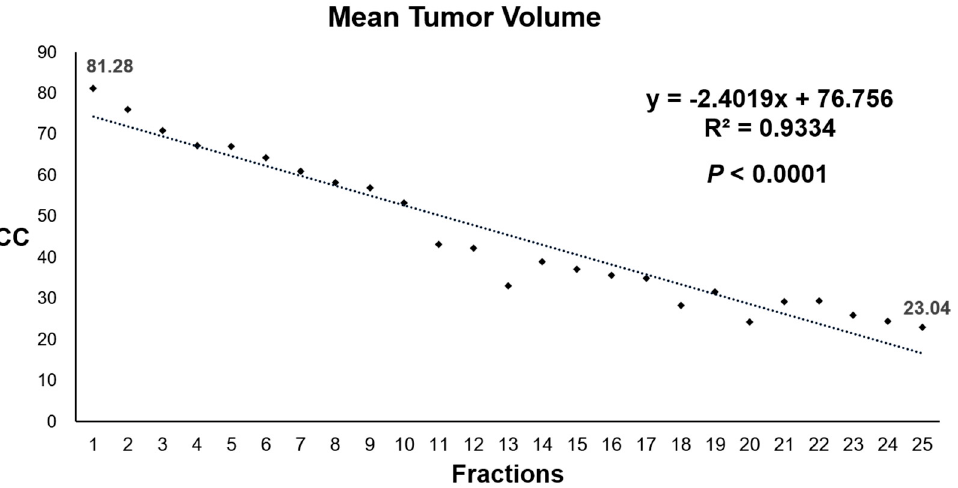
Figure 1. Mean values of absolute tumor volume (cc) at each fraction of 20 patients who underwent chemoradiotherapy.